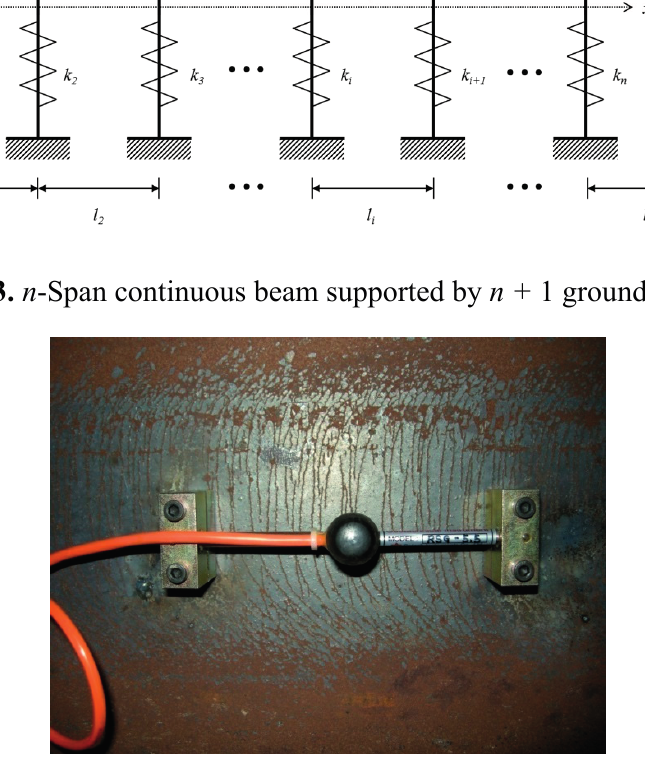
Figure 4. Typical vibrating wire strain gauge attached to the surface of a steel section for measurement of average